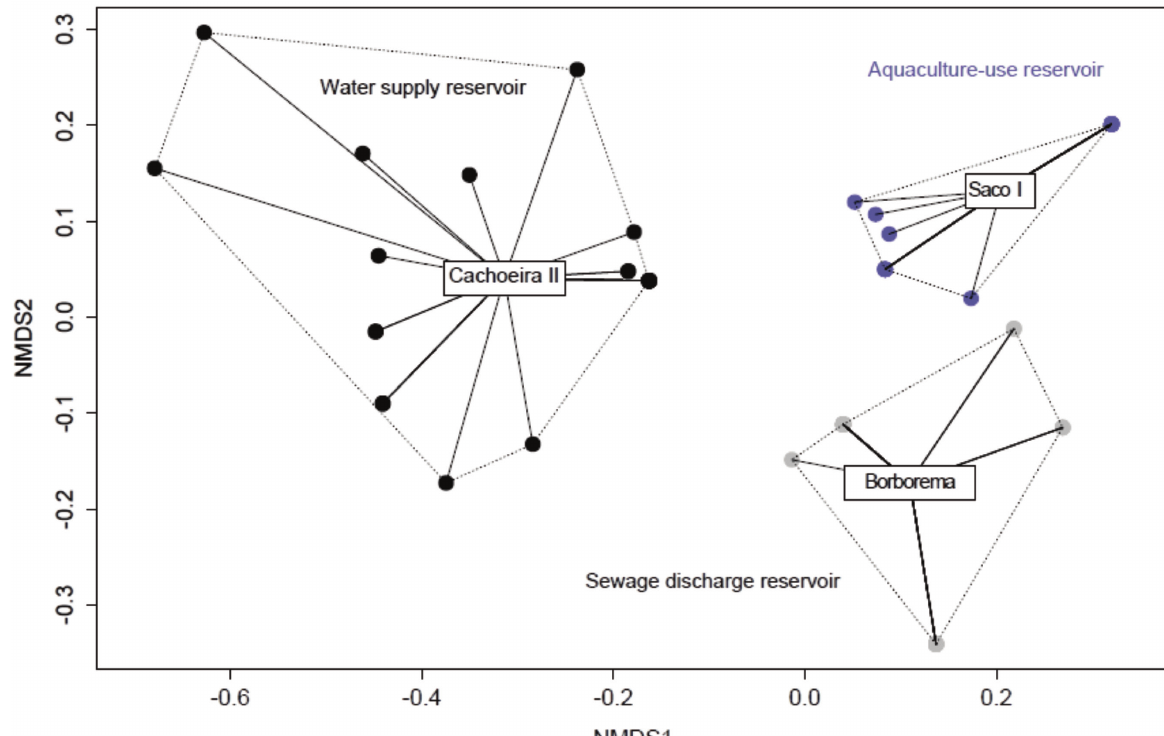
Figure 5 - Non-metric multidimensional scaling with the data of the cladoceran and copepod composition from three reservoirs in a tropical semiarid basin (Pajeú